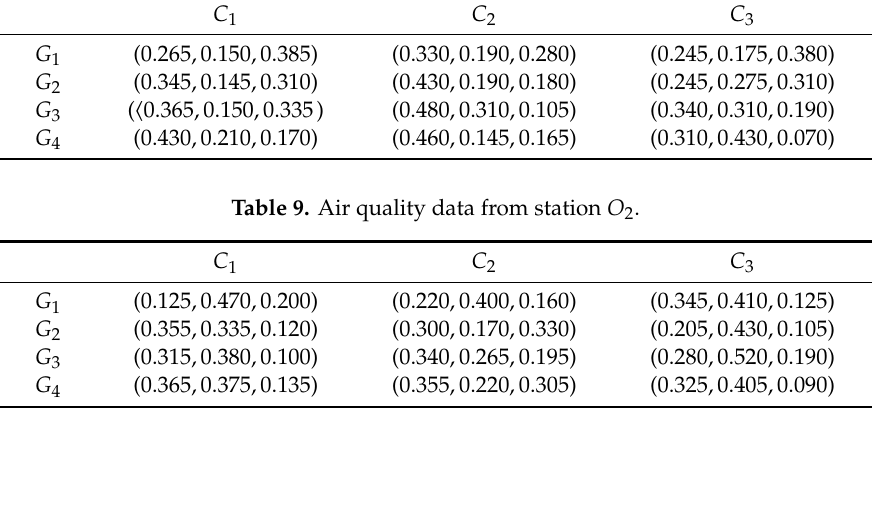
Table 10. Air quality data from station O 3 .